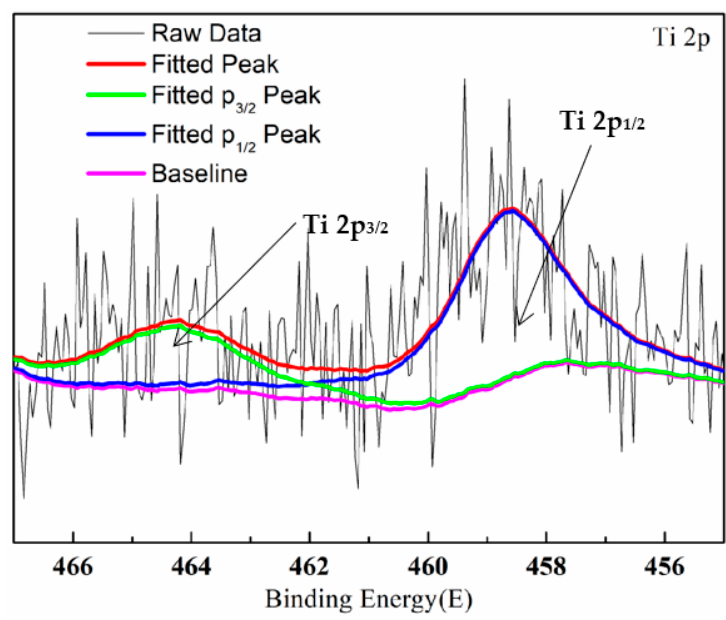
Figure 7. XPS diagram of Ti5 ‐ 15 MAO film.